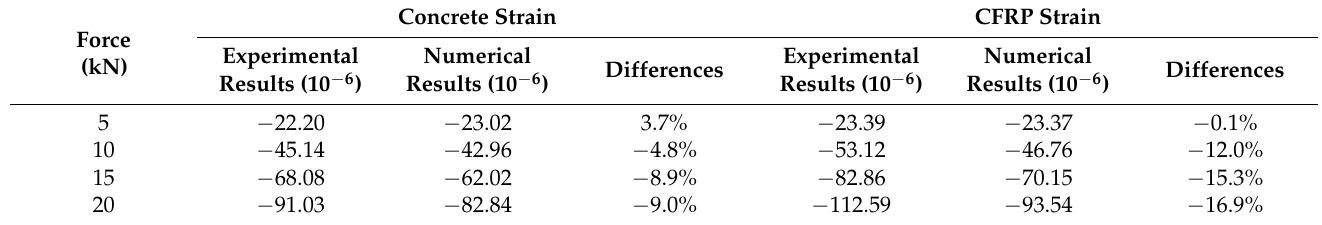
Table 4. Comparison between the experimental results and analytical results.